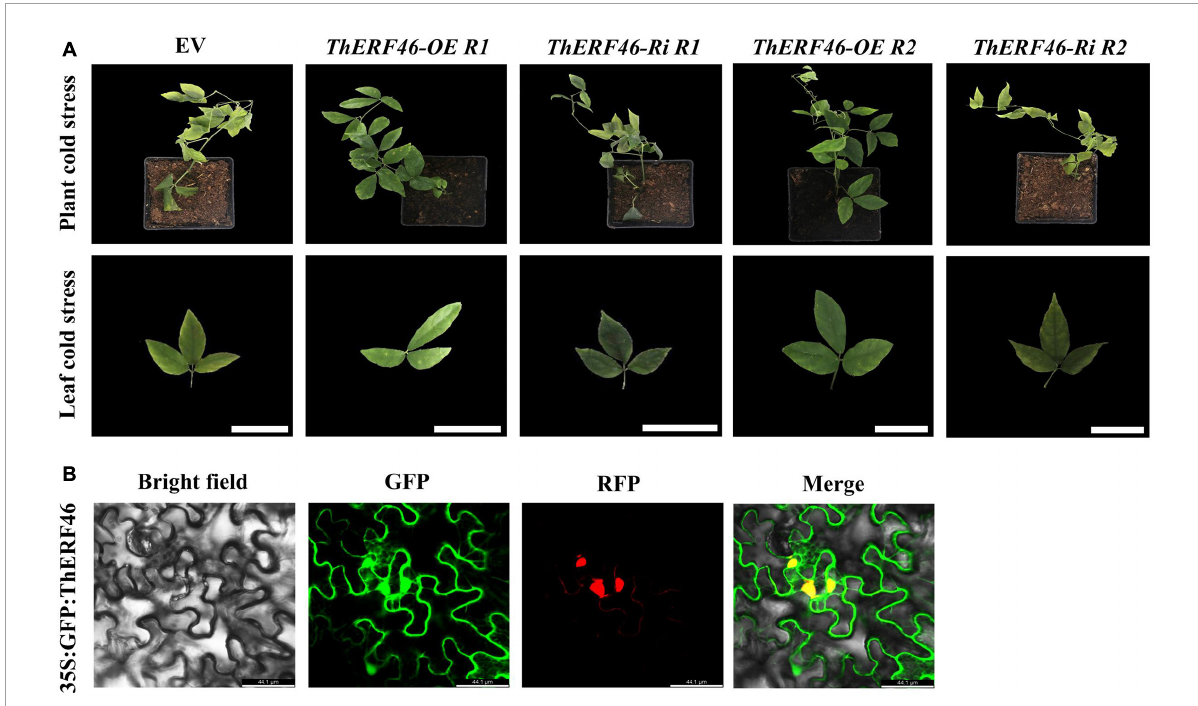
FIGURE4 Phenotype and subcellular localization analysis of ThERF46 in T. hemsleyanum. (A) The phenotype of ThERF46 -OE, ThERF46 -Ri, and EV treatment under cold stress. EV, empty vector (the EV without an exogenous gene was used as the control); R1, Repeat 1; R2, Repeat 2. (B) Subcellular localization of ThERF46 in N. benthamiana. GFP, green fluorescence protein; RFP, red fluorescence protein (used as a marker of nucleus localization signals). Three biological replicates for each treatment. Bar, 0.5